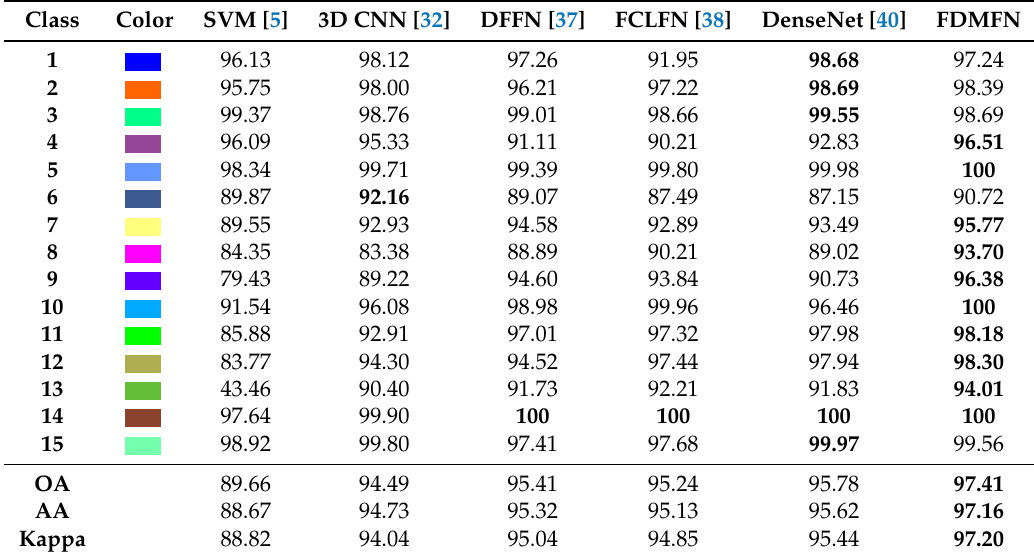
Table 7. Classification accuracies (in %) of different methods for the UH dataset using 5% of labeled samples for training. The best results are highlighted in bold font.